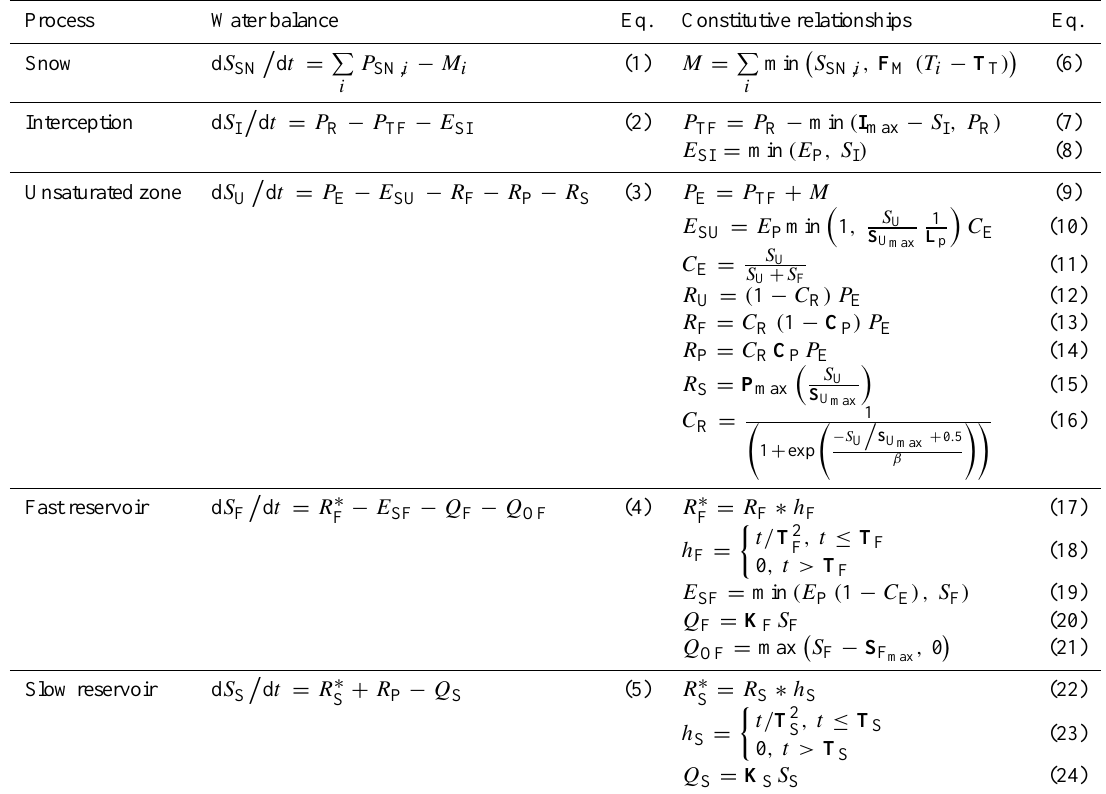
Table 2. State and flux equations of the models used in the analysis. Process Water balance